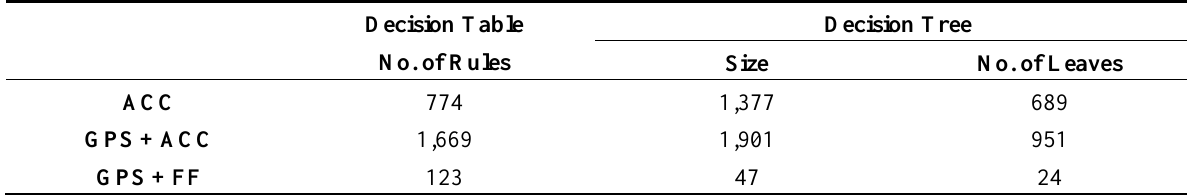
Table 3. Number of tree leaves, tree size (number of nodes) and number of rules for